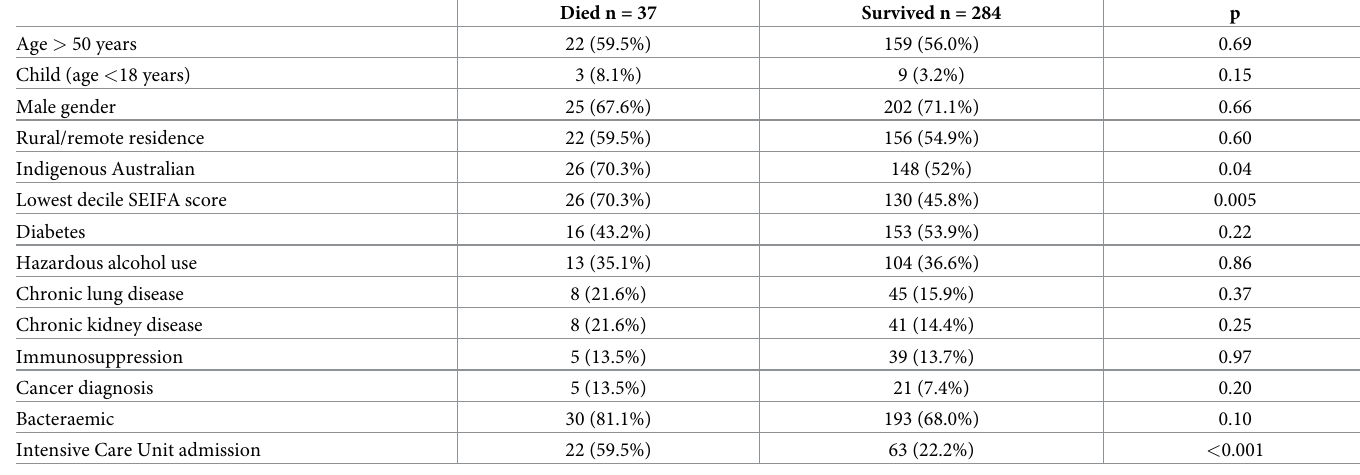
Table 5. Association between selected characteristics of cases of melioidosis and death.